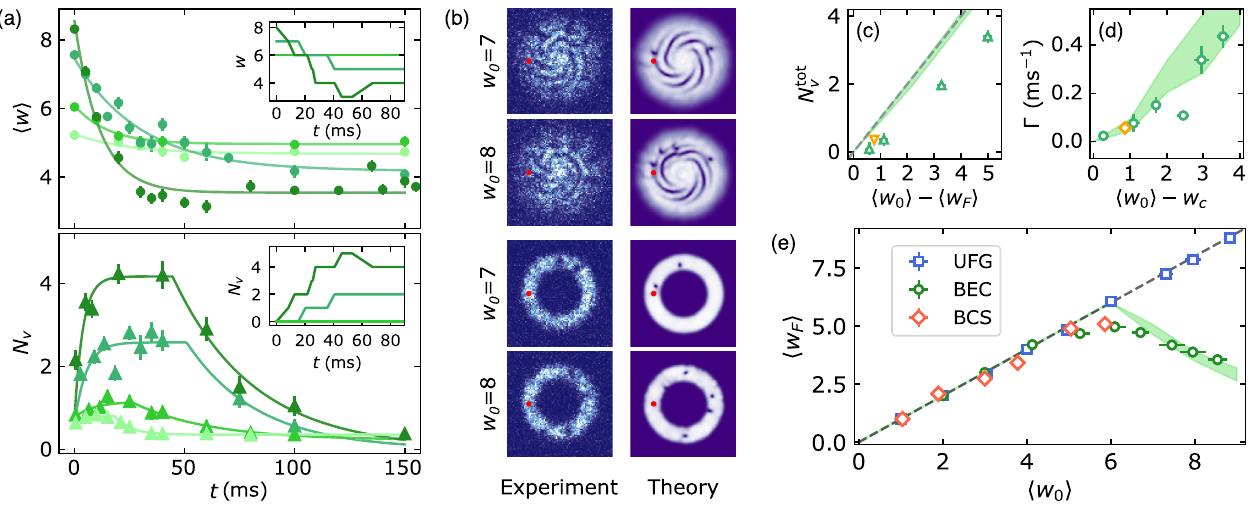
FIG. 4. Persistent current stability in the presence of a local perturbation. (a) Average circulation h w i and number of vortices N v a ≃ 3 . 6 ). Symbols with the same measured after a time t from the introduction of a controlled point defect in the ring BEC superfluid ( 1 =k F color share equal starting experimental conditions; darker shades of green correspond to higher initial circulation. Data in the bottom panel are acquired by ramping up the optical defect 300 ms after the excitation of the persistent current, to have on average less than one vortex generated by the imprinting remaining in the ring. Solid lines represent an exponential fit for h w i , and an exponential charging and discharging fit for N . Insets: GPE numerical simulation results of the same quantities, plotted using the same color convention. v (b)Comparison between experimental andGPEsimulated interferograms (top) andsimple ringTOF(bottom) inthe presence ofthe defect. The position of the defect is marked by a red dot in each image. Experimental interferograms are obtained at t ¼ 20 ms, and the numerical ones at t ¼ 40 ms and t ¼ 28 ms for w 0 ¼ 7 and w 0 ¼ 8 , respectively. The experimental (numerical) images of vortices in the ring are obtained for t ¼ 5 ms and t ¼ 40 ms ( t ¼ 24 ms and t ¼ 53 ms) for w 0 ¼ 7 and w 0 ¼ 8 , respectively. The time shift between experimental and numerical images of vortices accounts for the 13-ms time interval taken to remove the obstacle in the experiment. (c,d) Fitted values of the total number of emitted vortices N tot and windingnumber decay rate Γ ¼ A= τ ,where A is the amplitude and τ the decay v a ≃ − 0 . 4 BCS (orange symbols) superfluids. The gray dashed line in time from the exponential fit, for BEC (green symbols) and 1 =k F w 0 i − h w panel (c) marks N tot .(e) Stability of thecirculation forfermionic superfluids (see legend)inthe presence ofa localdefectof v ¼ h F i a ≃ 0 and BCS superfluids. For h w 0 i > w height V 0 ≃ 0 . 1 E in a BEC and V 0 ≃ 0 . 2 E in unitary (UFG) at 1 =k , the final winding F F F c number h w is obtained from the exponential fit of the current decay, whereas for h w 0 i ≤ w , it simply represents the measured average F i c circulation at t ≥ 150 ms. In panels (c) – (e), the results obtained from an exponential fit of the GPE numerical simulations are reported as green shaded regions. Error bars in panel (a) denote the SEM, while in panels (c) – (e), they represent the 1 σ uncertainty of the